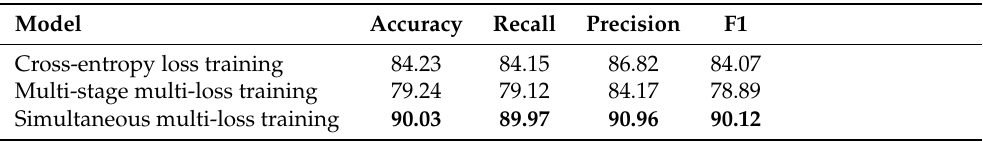
Table 2. Evaluation metrics for testing the three different approaches in the multi-user test dataset. These values are the average of the metrics calculated for each